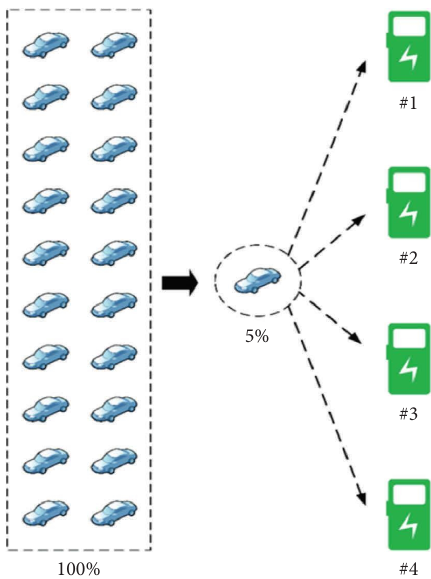
Figure 5: Characteristics of EVs receiving services at public charging